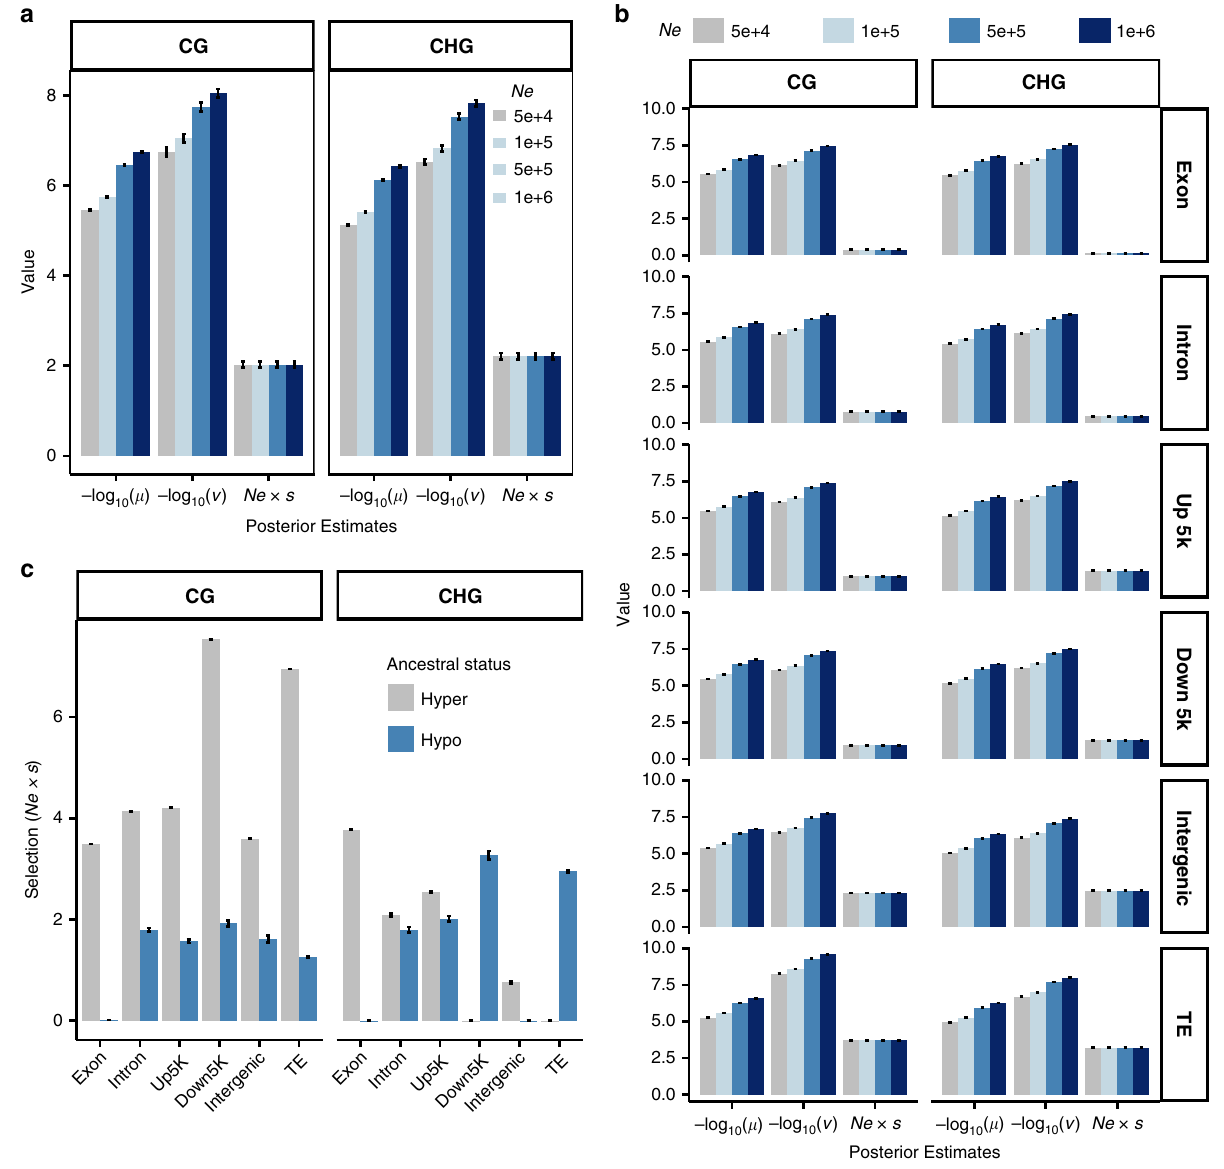
Fig. 1 Population genetic parameters inference. a Posterior estimate of mean values and standard deviations for µ , ν , and N e × s for CG and CHG sites using four different effective population size ( N e ) values. b Posterior estimates for different genomic features. Up 5 k, the upstream 5 kb region of a gene; Down 5 k, the downstream 5 kb region of a gene. c Posterior estimates by de fi ning teosinte as the ancestral epiallele. Values were estimated using MCMC approach with 20% burnin (see “ Methods ” ). Error bars indicate SDs ( N = 1600 for each bar). Source data underlying a – c are provided as a Source Data fi